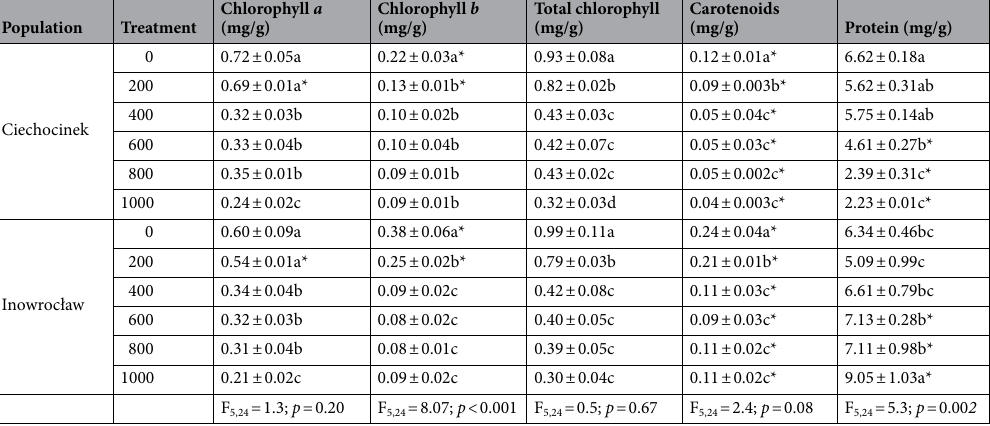
Table 1. Changes in the chlorophylls a , b , total, carotenoid and total soluble protein content in S. europaea populations (Inowrocław and Ciechocinek) under NaCl stress. Means and ± SD of replicates. Different letters indicate significant differences between treatments within population and * indicates significant difference between populations within treatment (p < 0.05), n = 3. The F values correspond to the 2-way ANOVA interaction salt treatment × population.